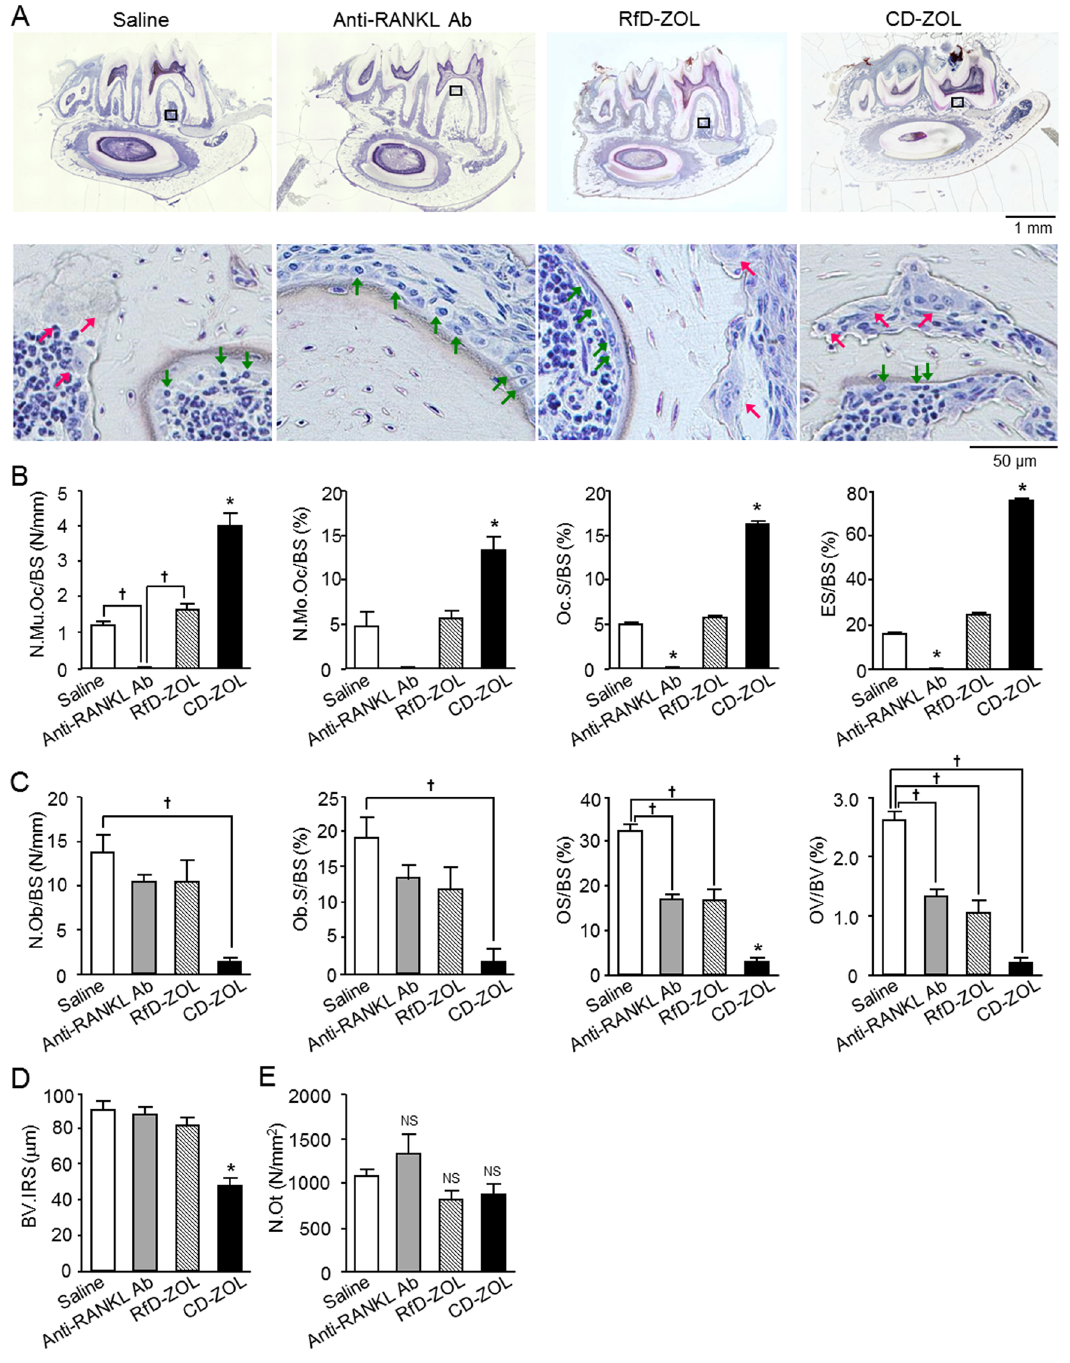
Figure 4. Effects of long-term administrations of anti-RANKL antibody or zoledronic acid on mandibular alveolar bone. ( A ) Villanueva staining of mandibular alveolar bone of 8-week-old mice administered saline, anti-RANKL antibody (Ab) at 2.5 mg/kg, RfD-ZOL at 0.08 mg/kg, or CD-ZOL at 3.0 mg/kg weekly for 7 weeks. Higher magnification images of black-boxed regions in upper panels are shown in lower panels. Green arrows indicate osteoblasts and red arrows osteoclasts. Representative results are shown. ( B – E ) Mandibular alveolar bone static parameters were determined using bone morphometric analysis, including ( B ) number of multinucleated osteoclasts (N.Mu.Oc/BS), number of mononuclear osteoclasts (N.Mo.Oc/BS), osteoclast surface (Oc.S/BS), and eroded surface area (ES/BS) on the bone surface, ( C ) number of osteoblasts (N.Ob/ BS), osteoblast surface (Ob.S/BS), osteoid surface area (OS/BS) on bone surface, and osteoid volume per bone volume (OV/BV), ( D ) bone volume of interradicular septum (BV.IRS), and ( E ) number of osteocytes (N.Ot). Four mice from each of the saline, anti-RANKL Ab, RfD-ZOL, and CD-ZOL groups were used. Statistical differences were assessed by one-way ANOVA with Tukey-Kramer’s test. Statistically significant different from compared to * all the other groups, or † indicated groups, p < 0.05. Error bars represent